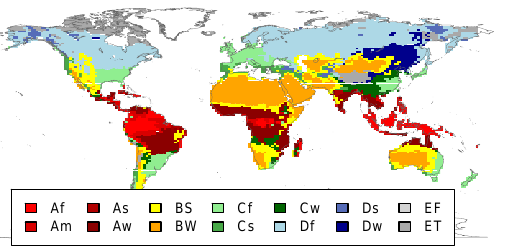
Figure 4. The fraction of dominant uncertainty source in each Köppen climatic divisions in (cid:49) NPP (a) , (cid:49) VegC (b) , (cid:49) SOC (c) , (cid:49) VegC residence time (d) in the 2090s, and Köppen climate classification map for the period 1951 to 2000 from the Climatic Research Unit (CRU) (e) . In panels (a–c) , the colors indicate each uncertainty source as in Fig. 2 (i.e., orange indicates RCP, yellow indicates GCM, and blue indicates